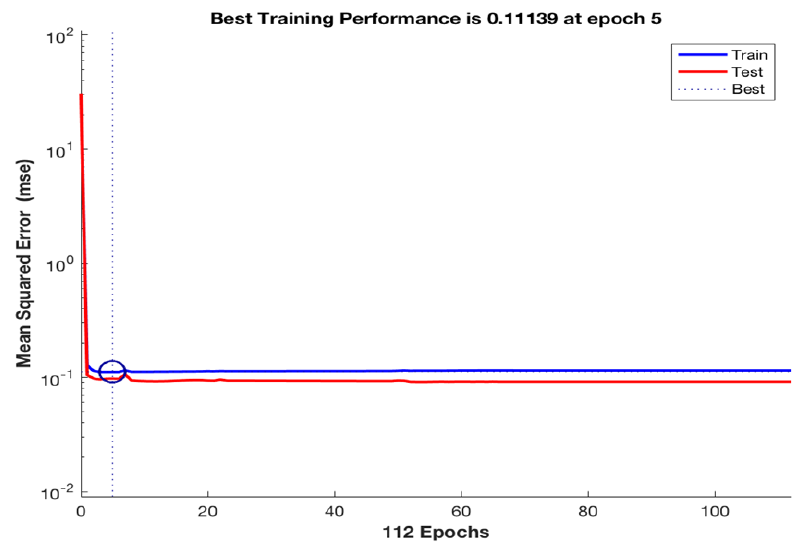
Figure 8. Distribution of EE Mean Squared Error (MSE) for general physical activity exercise con- ditions.